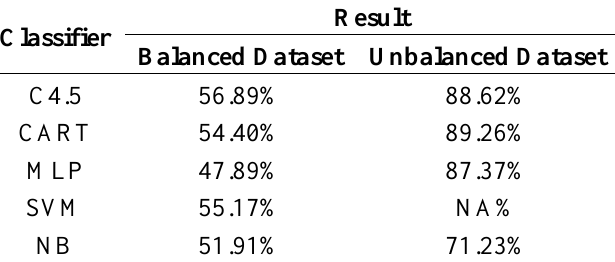
Table 5. Smartwatch-based activity